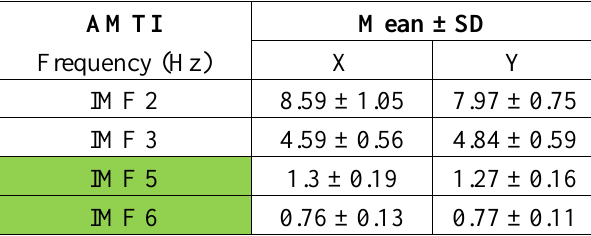
Table 5. IMF frequencies for